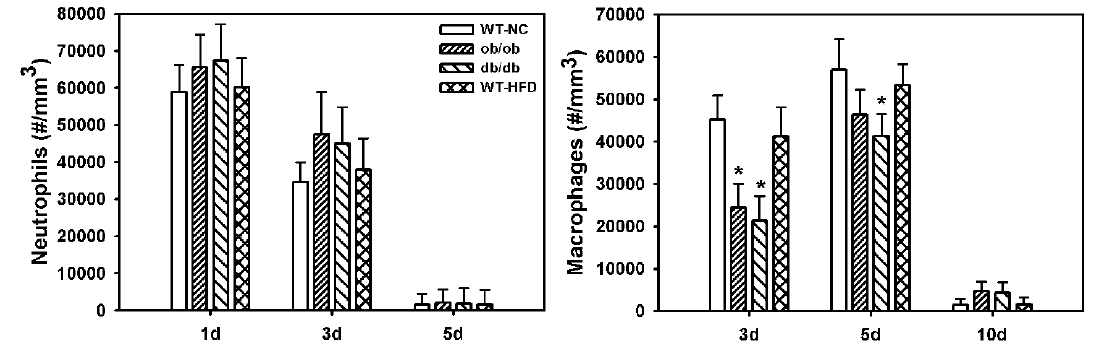
FIGURE 3. Neutrophil and macrophage accumulation following muscle injury. Injured muscles collected from WT mice fed NC, ob/ob mice, db/db mice, and WT mice fed HFD. Left: summary data for neutrophil accumulation assessed on days 1, 3, and 5 postinjury by immunostaining for the neutrophil- specific Ly6G antigen, counting number of Ly6G + cells per cryosection, and normalizing to cryosection volume. Right: summary data for macrophage accumulation assessed on days 3, 5, and 10 postinjury by immunostaining cryosections for the macrophage-specific F4/80 antigen, counting number of F4/80 + cells per cryosection, and normalizing to cryosection volume. Bars are means ± standard error, n = 4–6 per time point. *= Mean value significantly smaller than that for WT-NC mice; p < 0.05.